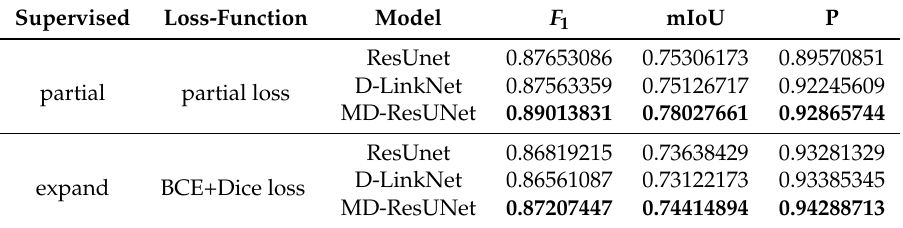
Table 3. Different performance of road extraction using different annotation with different loss functions in dataset 1.